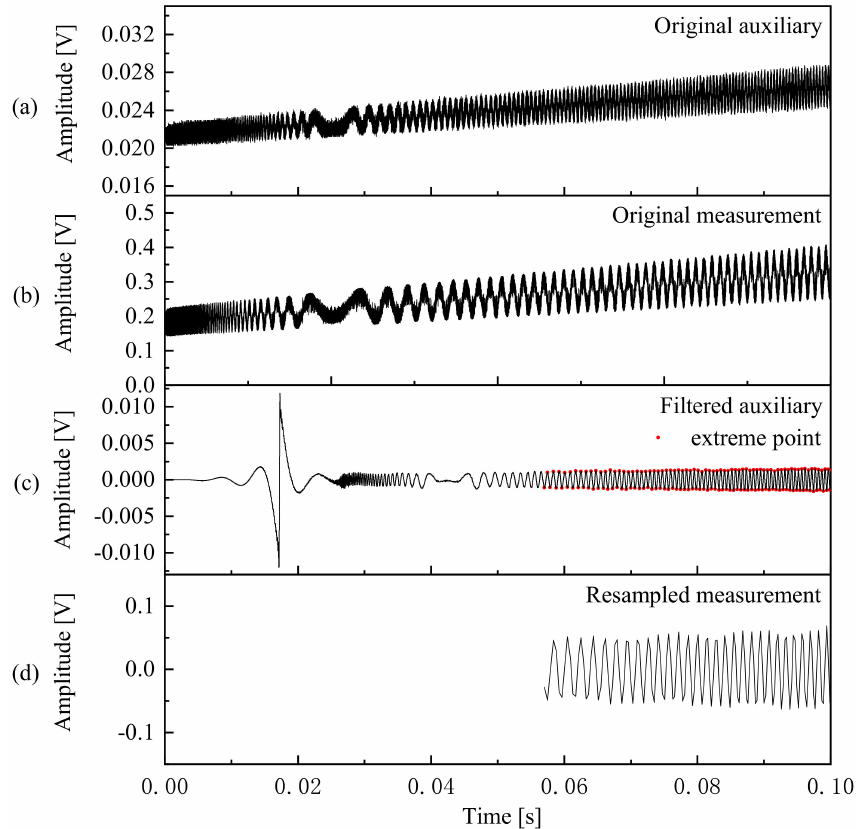
Figure 7. Interference signals. ( a ) Original auxiliary; ( b ) original measurement; ( c ) filtered auxiliary; ( d ) resampled measurement. Here, only a 0.1 s signal of the entire 1 s interference is demonstrated to show the signal characteristics more clearly.